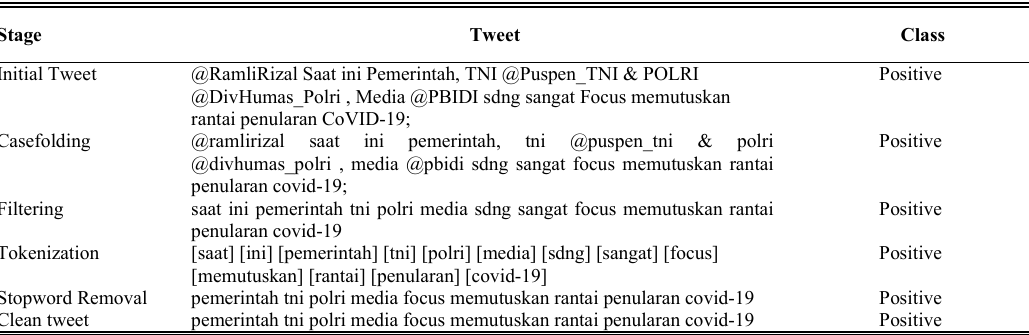
TABLE 1 E XAMPLE OF P RE - PROCESSING STAGES AND THE